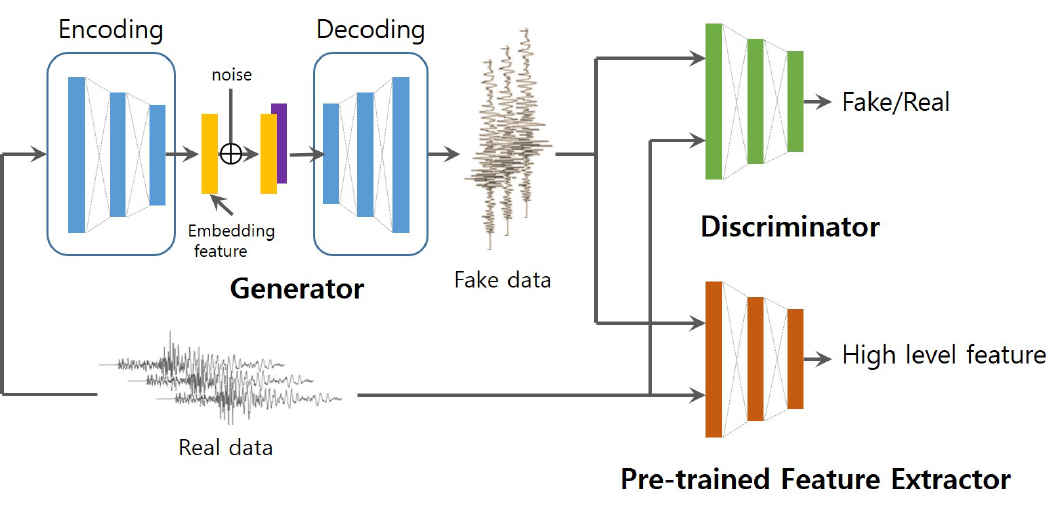
Figure 3. Architecture of proposed model.